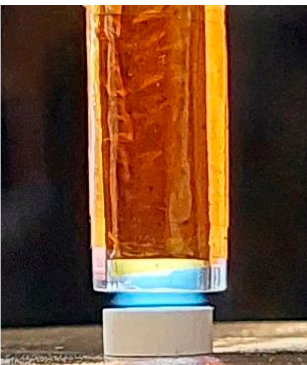
Figure 7. Plasma treatment on the HAP sample using the planar DBD